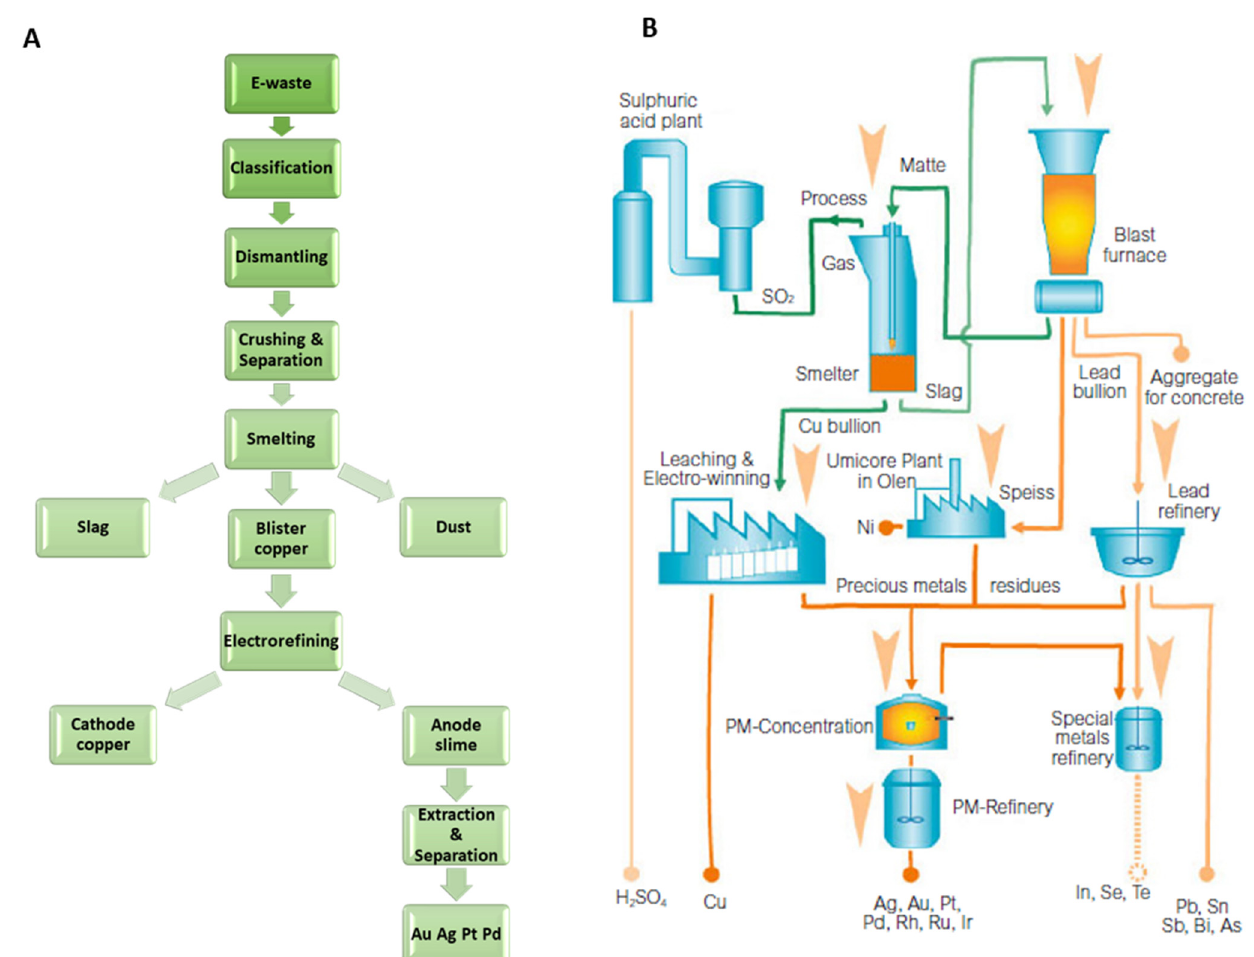
Figure 3. Flowsheets of ( A ) precious metals being recycled from WEEE by a pyrometallurgical process, reproduced with permission from [39] and ( B ) simplified plan of the Umicore integrated smelter ‐ refinery plant, reproduced with permission from [40]. Table 1. Summary of the different lixiviant systems for gold extraction from WEEE [33,44].